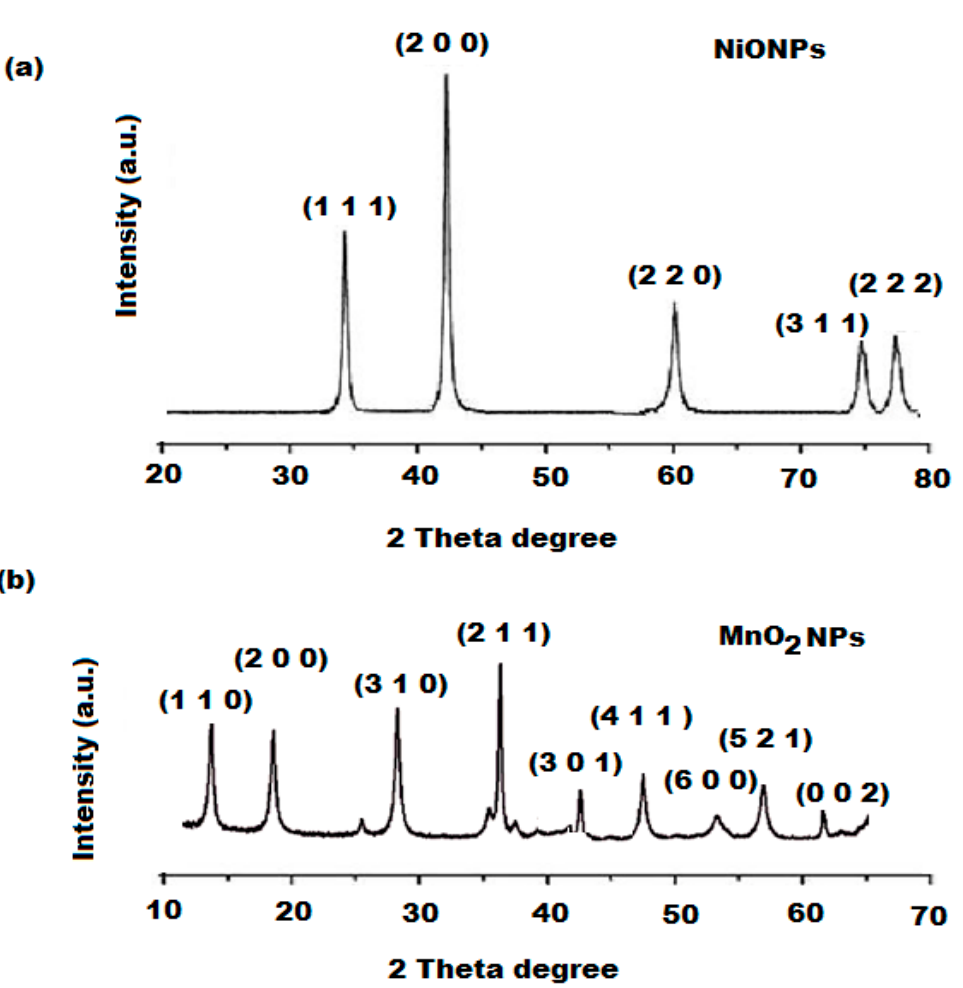
Figure 4. XRD spectra of the green synthesized ( a ) NiONPs and ( b ) MnO 2 NPs using Mentha spicata and Malus domestica peel extract, and Malus domestica peel extract, respectively.